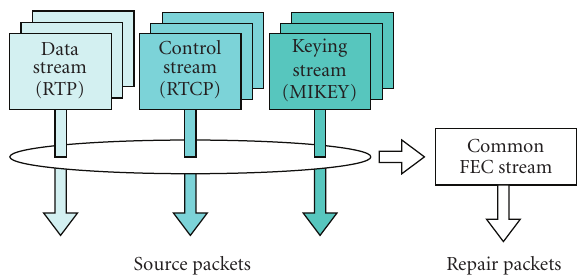
Figure 11: FEC Stream Bundling